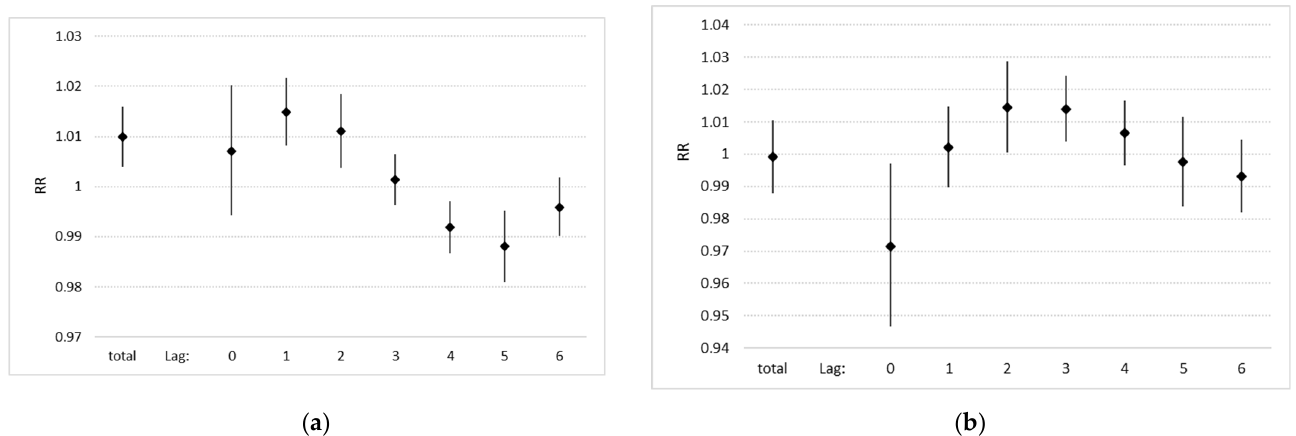
Figure 2. Effect (relative risk and 95% confidence interval) per 10 μ g/m³ increase in PM2.5, total effect and daily effects over 7 consecutive days (lag 0–6): ( a ) ambulatory visits, ( b ) stationary hospi ‐ tal